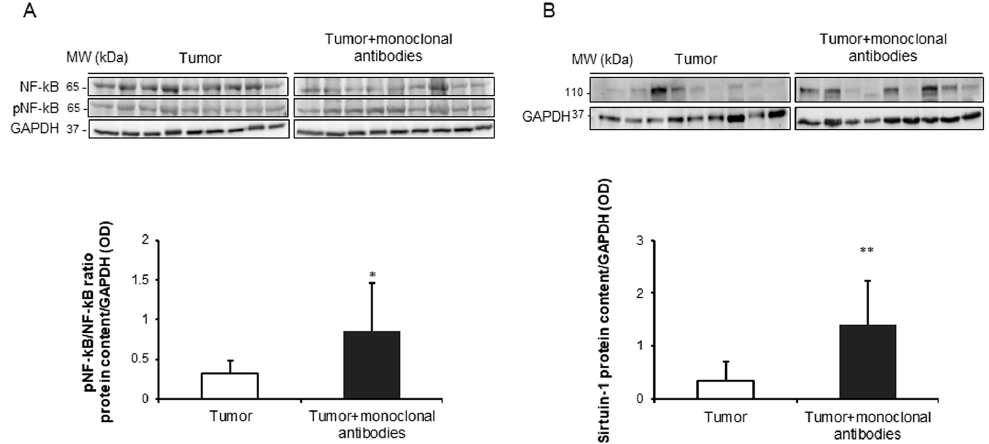
Figure 8. ( A ) Representative immunoblots and mean values and standard deviation of ratio of pNF- κ B/NF- κ B protein levels/GAPDH in subcutaneous tumors of lung cancer mice as measured by optical densities. ( B ) Representative immunoblots and mean values and standard deviation of sirtuin-1 protein levels/GAPDH in subcutaneous tumors of lung cancer mice as measured by optical densities.